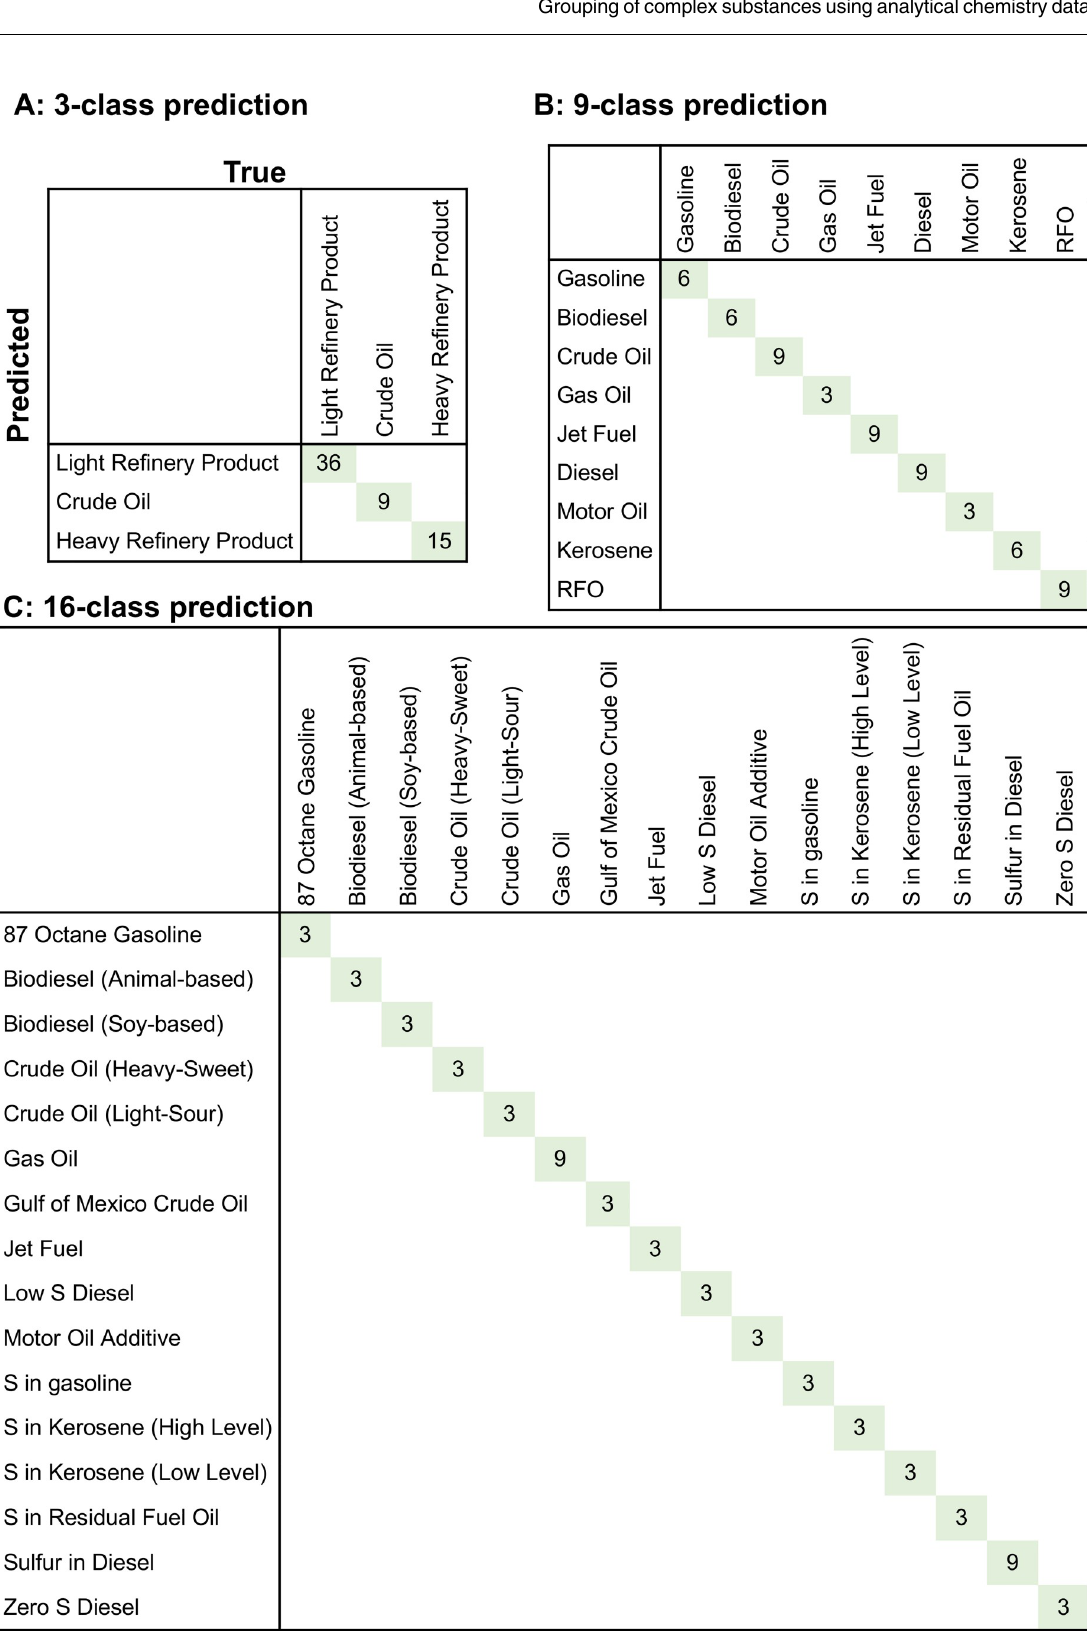
PLOS ONE | https://doi.org/10.1371/journal.pone.0223517 October 10,